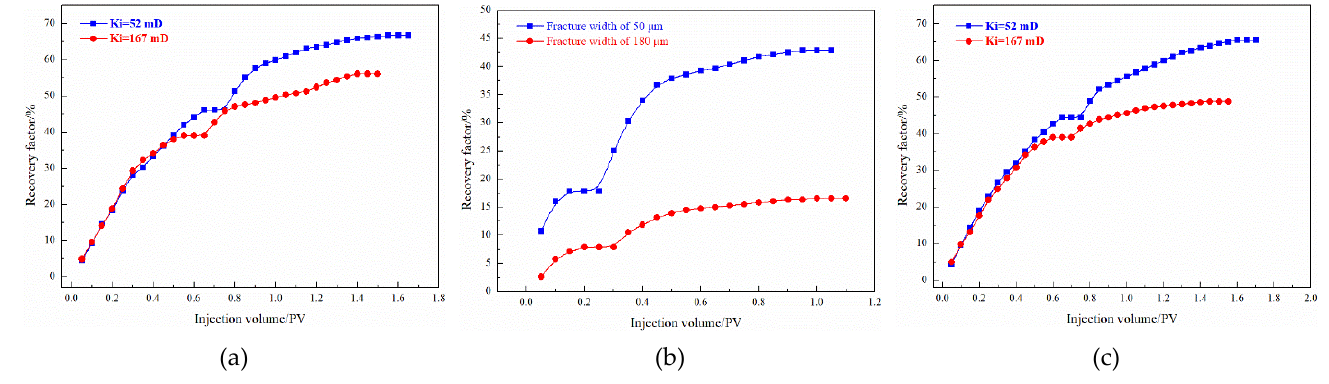
Figure 17. EOR effects of enhanced foam with WQ-100: ( a ) pore reservoirs, ( b ) fracture reservoirs, ( c ) pore-fractured reservoir.